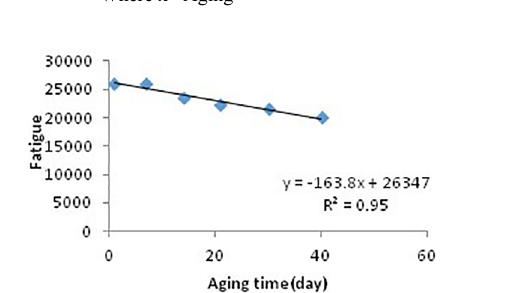
Figure 9. Fatigue vs. Aging time